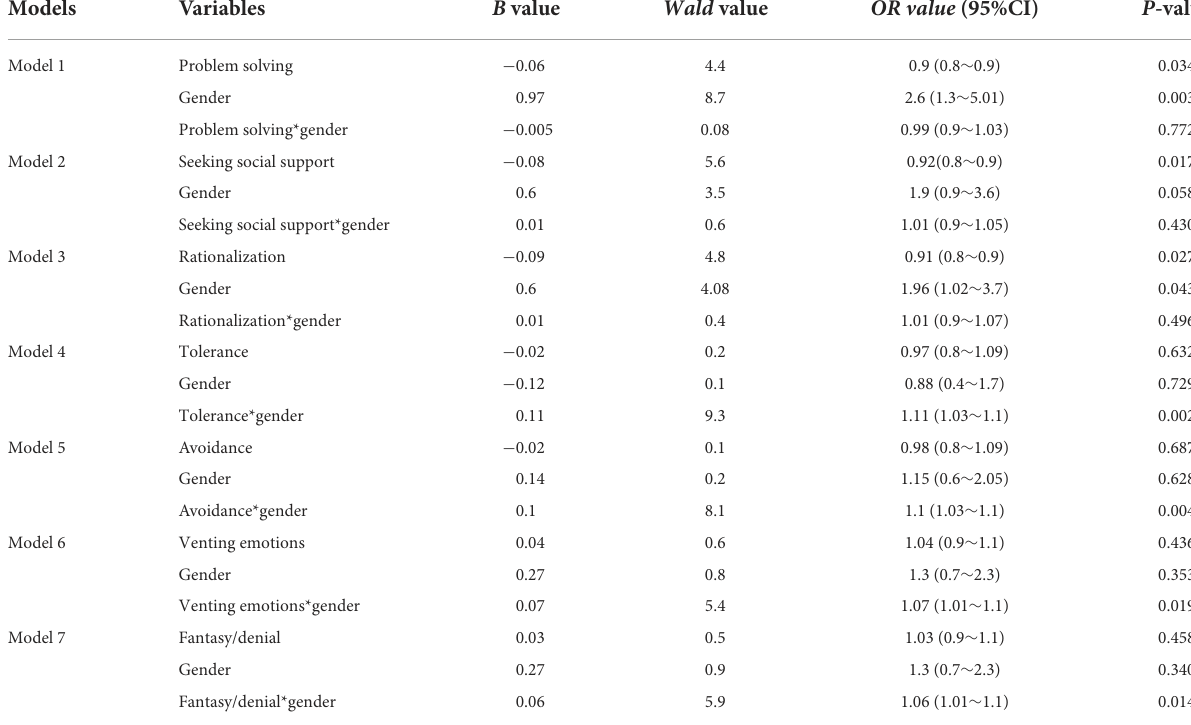
TABLE 4 Regression analysis of the interaction of the factors of coping style and gender with NSSI.